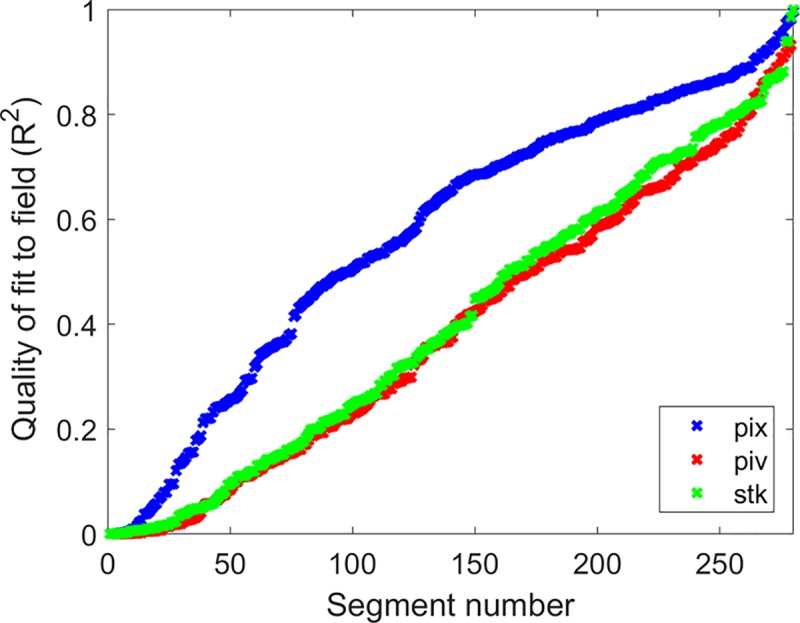
Correlation of velocities measured in each vessel segment to the field average.For each algorithm considered (blue = PIX, green = PIV, red = STK), the average velocity for all visible segments in a field was computed over several cardiac cycles to provide a surrogate for cardiac influence at the capillary level. This procedure was repeated over 7 non-overlapping fields acquired at 300 fps in 2 subjects, yielding a total of 280 unique vessel segments. The goodness of fit (R2) to the field average is plotted for each vessel. The higher R2 values obtained for the PIX algorithm indicate that it generally returned more physiologically plausible outputs under the imaging parameters used here.